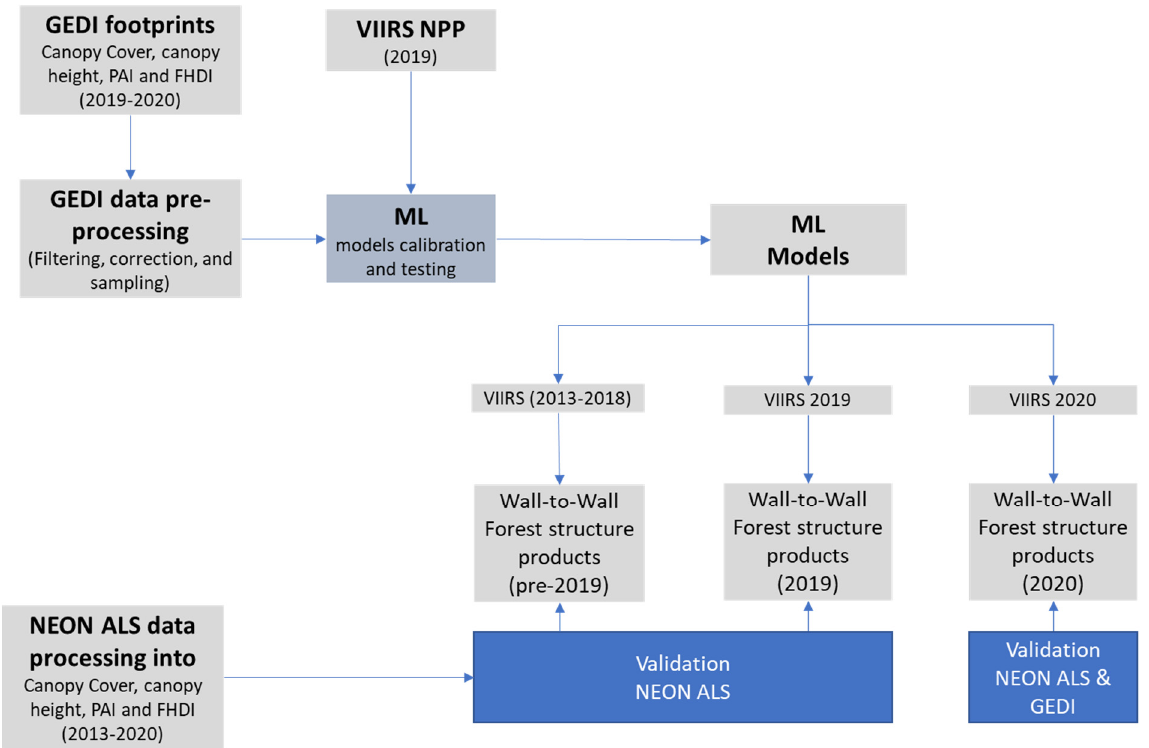
Figure 1. Flowchart of the steps used to produce and evaluate the accuracy of annual (2013–2020) wall-to-wall forest structure products. The canopy height, canopy cover, plant area index (PAI), and foliage height diversity index (FHDI) forest structure products were obtained by exploiting the synergy between VIIRS and GEDI measurements using Machine Learning (ML) algorithms. The models that were trained using the 2019 data were applied to the VIIRS observation period from 2013 to 2020. The uncertainties in the annual map products were then evaluated using airborne laser scanning (ALS) data collected for the National Science Foundation’s National Ecological Observatory Network (NEON) field sites in the U.S. mainland.